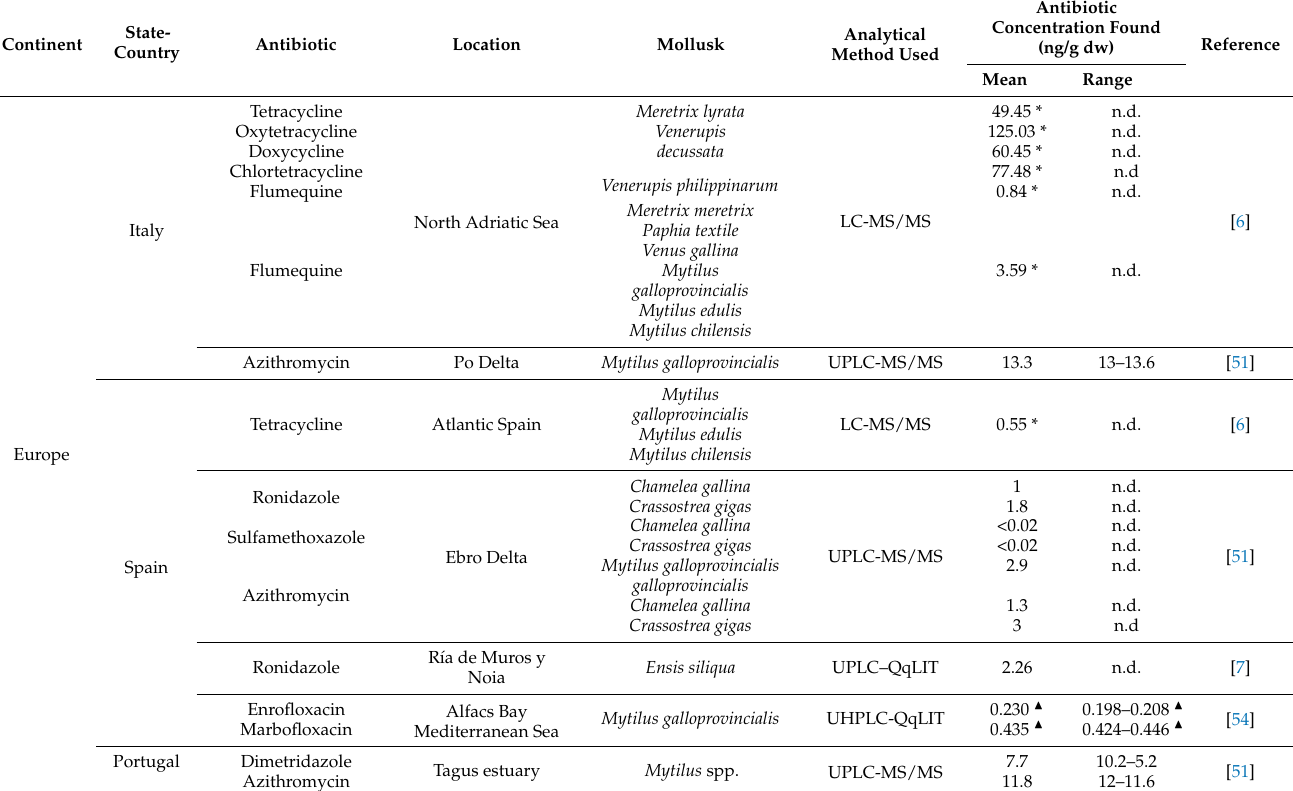
Table 2. Concentrations of antibiotics (ng/g) in bivalve mollusks harvested in the